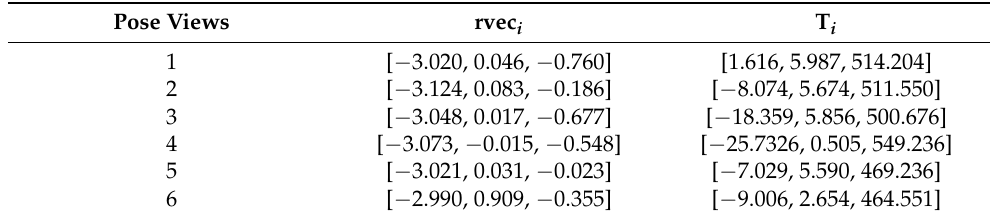
Table 3. The extrinsic parameters of the six pose views.